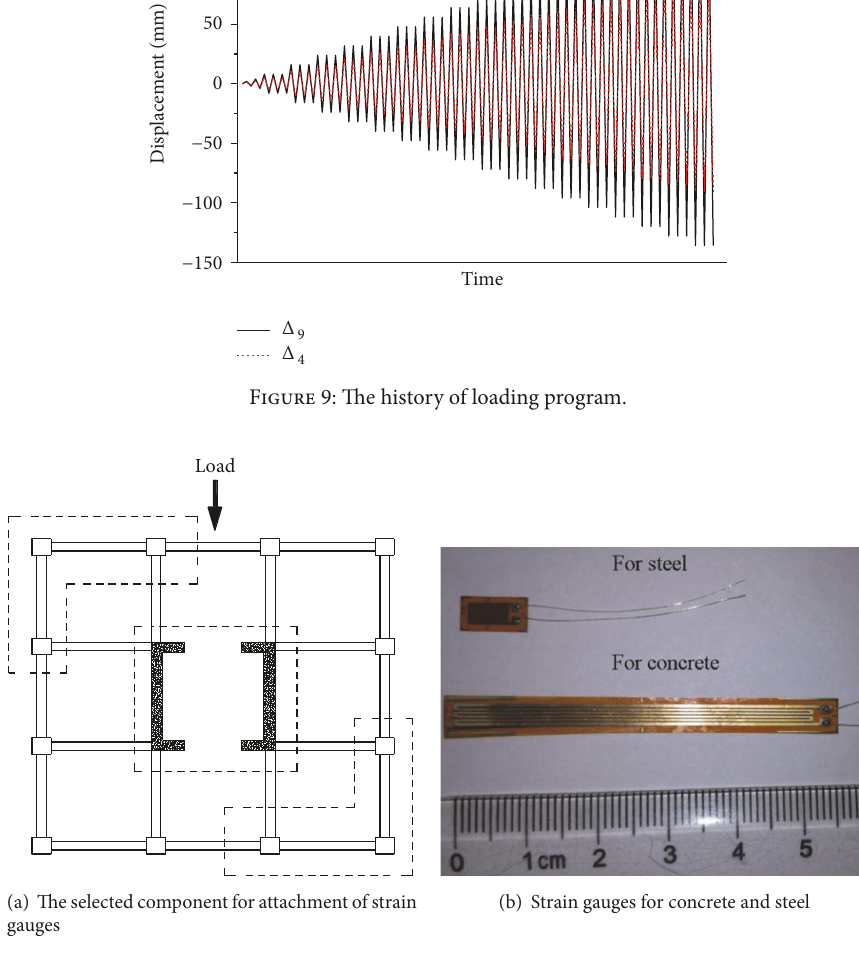
Figure 10: The arrangement of strain